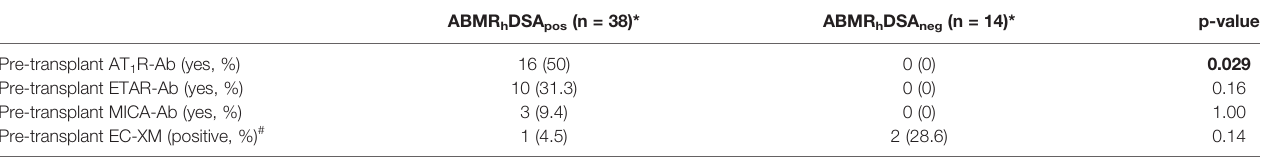
TABLE 3A | Comparison of pre-transplant non-HLA antibodies between ABMR h DSA pos and ABMR h DSA neg cases. ABMR h DSA pos (n = 38)* ABMR h DSA neg (n = 14)* p-value Pre-transplant AT 1 R-Ab (yes, %) 16 (50)